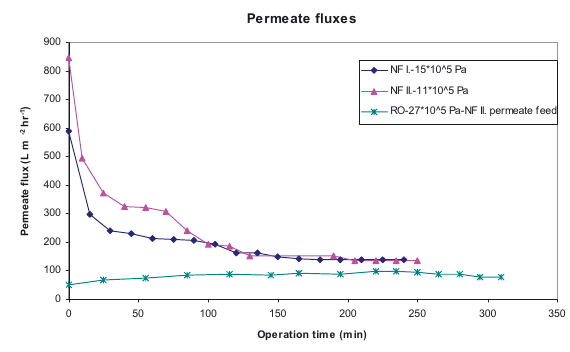
Figure 4. Permeate fluxes vs. operation time for wastewater of low COD.